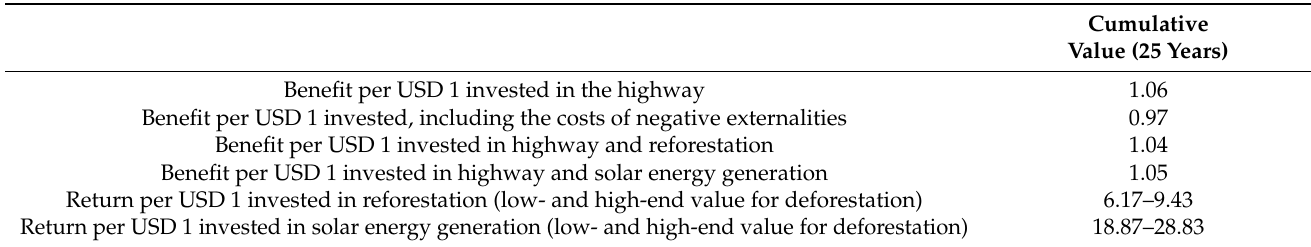
Table 5. Overview of the SAVi simulation results (in USD) for road infrastructure in Borneo [64].